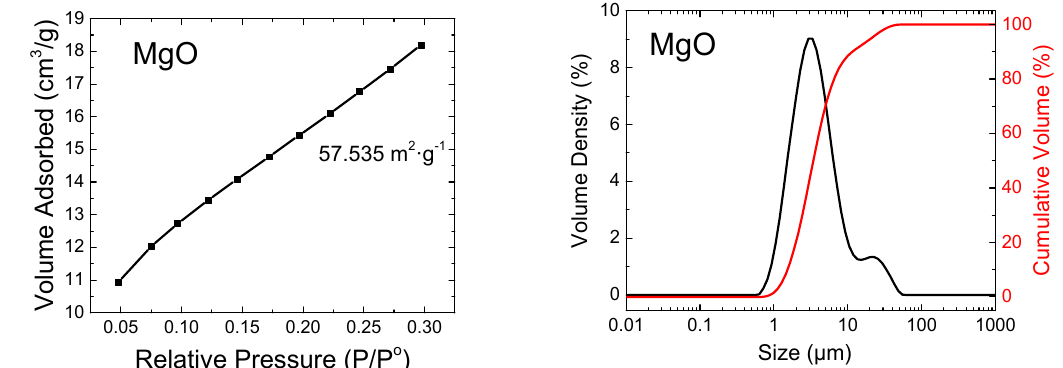
Figure1. Brunauer–Emmett–Teller(BET)surfaceareaofMgOpowder( left )andparticlesizedistribution Figure 1. Brunauer–Emmett–Teller (BET) surface area of MgO powder ( left ) and particle size of MgO cumulative and distribution curves ( right distribution of MgO cumulative and distribution curves ( right ).